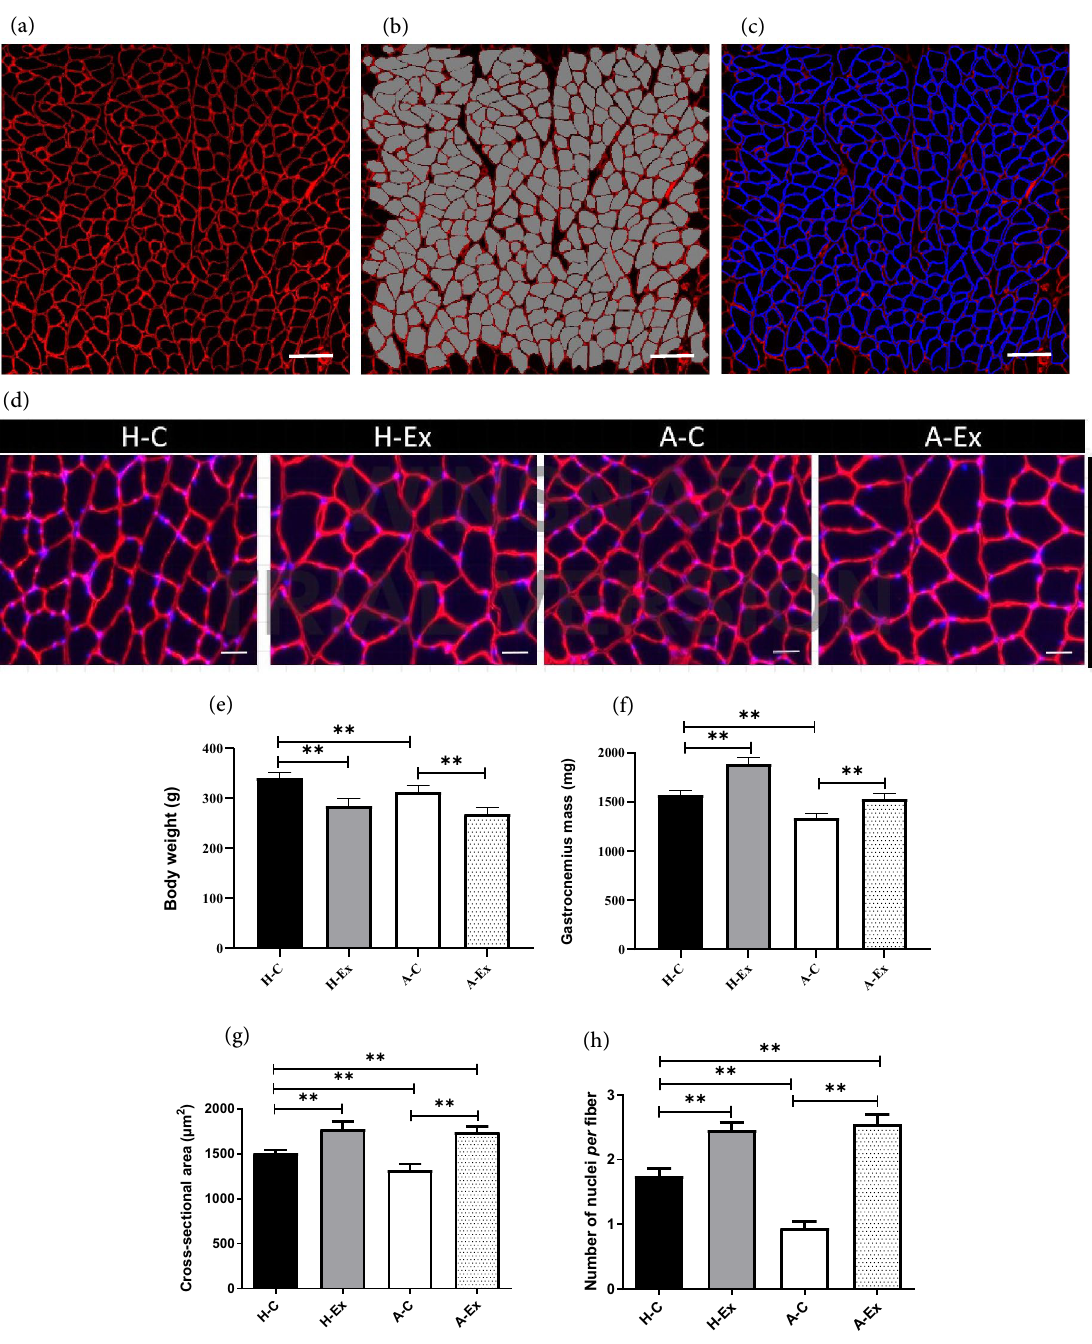
Figure 3. Muscle fiber cross-sectional area (CSA) in different experimental groups. ( a ) Gastrocnemius muscle cross section immunolabeled for Laminin (red). ( b , c ) Showing detection of region of interest and final detection process of myofibers by MyoView software. ( d ) Sections of gastrocnemius muscles immunolabeled for Laminin (red) and Hoechst (blue) for myonuclei detection process. ( e ) Body weight after training period. ( f ) gastrocnemius muscle weight. ( g ) Average gastrocnemius muscle CSA and ( h ) myonuclei numbers. Image analysis was performed using MyoView software 7 . Scale bar = 50 µm. ** p <